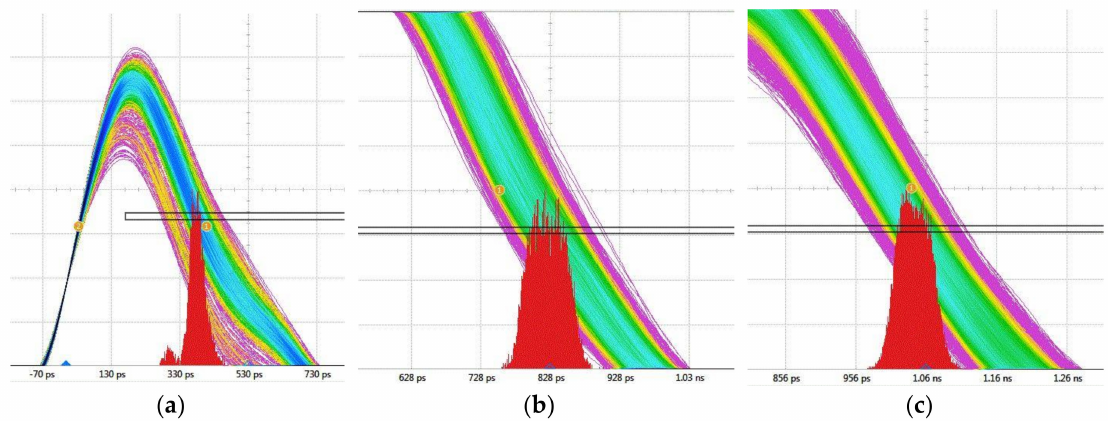
Figure 10. Jitter measurements of three different optical pulse widths: ( a ) t FWHM = 500 ps, σ t = 28 ps; ( b ) t FWHM = 750 ps, σ t = 24 ps; ( c ) t FWHM = 1 ns, σ t = 22